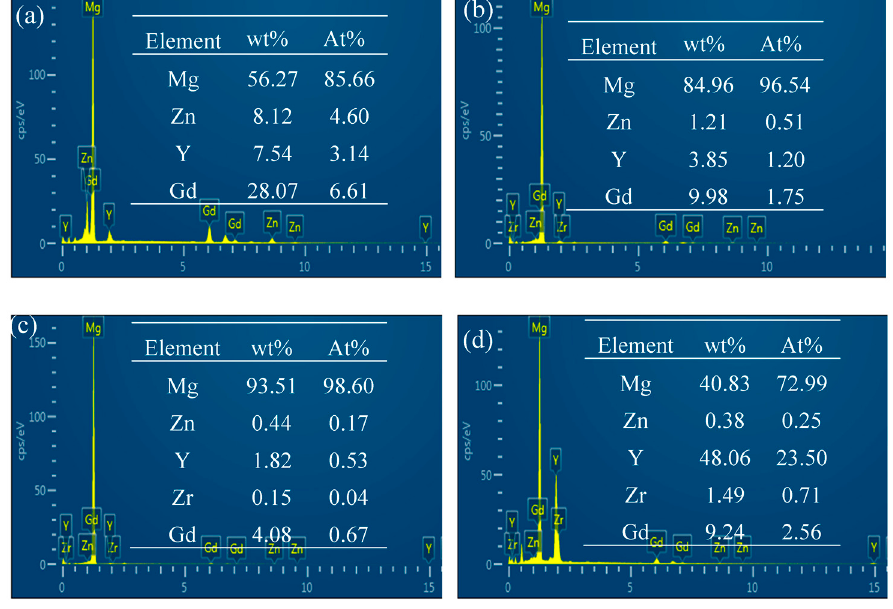
Figure 4. Analyzed chemical compositions of various areas marked in Figure 3b: ( a ) Area I; ( b ) area II; ( c ) area III; ( d ) area IV.